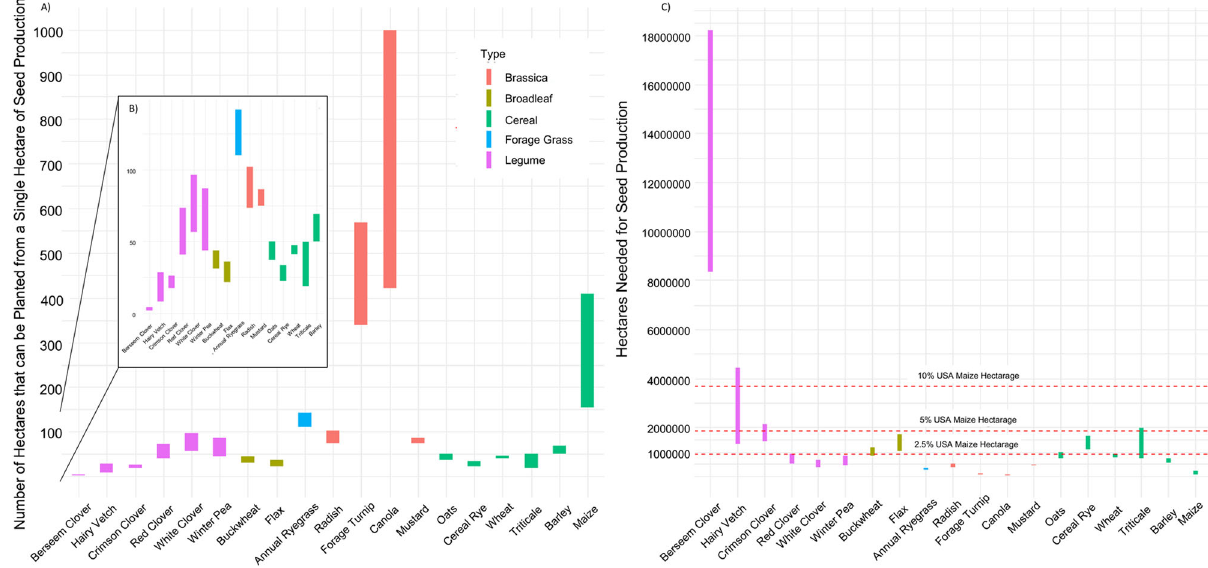
Figure 2 and in the presentation of the data in the text. Supplementary Data 1 has now been replaced with a fi le containing the correct numbers. Figure 2 has been